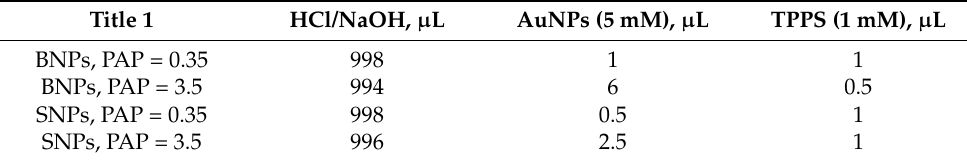
Table 1. Volumes used for the preparation of the nanohybrids